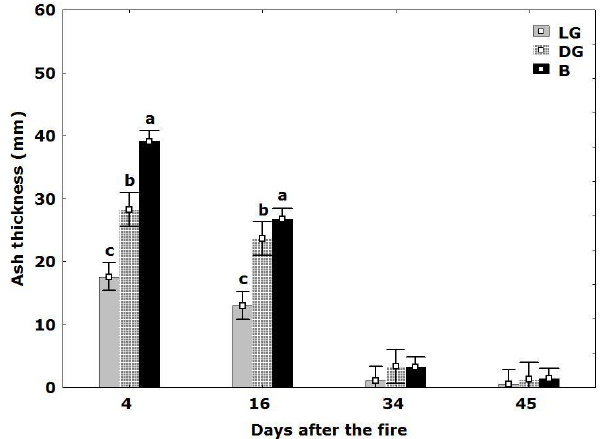
Fig. 2. Evolution of mean ash thickness in the flat area in the post-fire period (bars show 95% confidence intervals). Different letters indicate significant differences (p<0.05) between ash types (DG, dark grey ashes; B, black ashes; LG, light grey ashes).